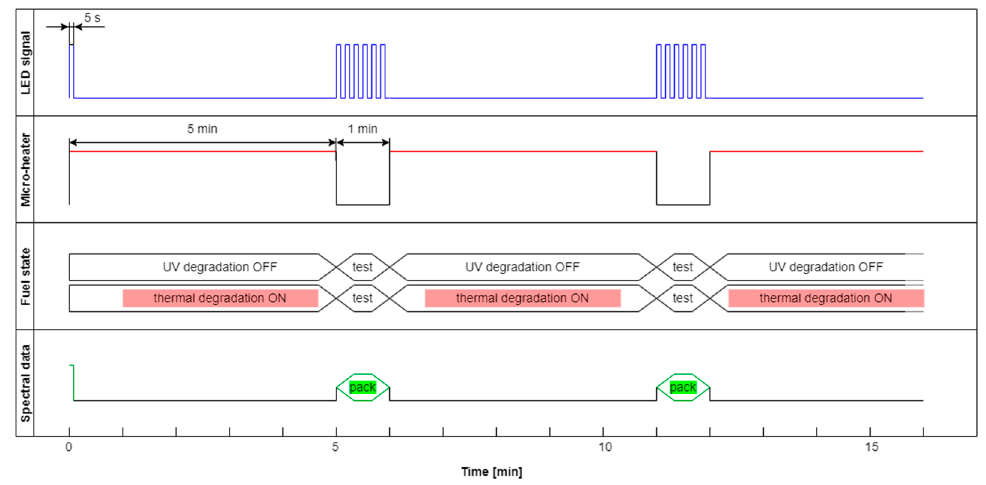
Figure 22. The modulated cycle of degradation and examination uses thermal radiations for degra- dation and modulated UV for analysis, named DME:UVoffTon.